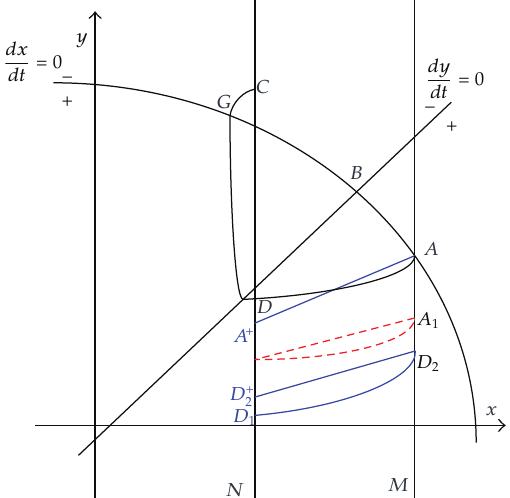
Figure 4: Illustration of system (cid:6) 1.3 (cid:7) for the case h > x ∗ , (cid:6) 1 − p (cid:7) h < x ∗ , x G < (cid:6) 1 − p (cid:7) h , y